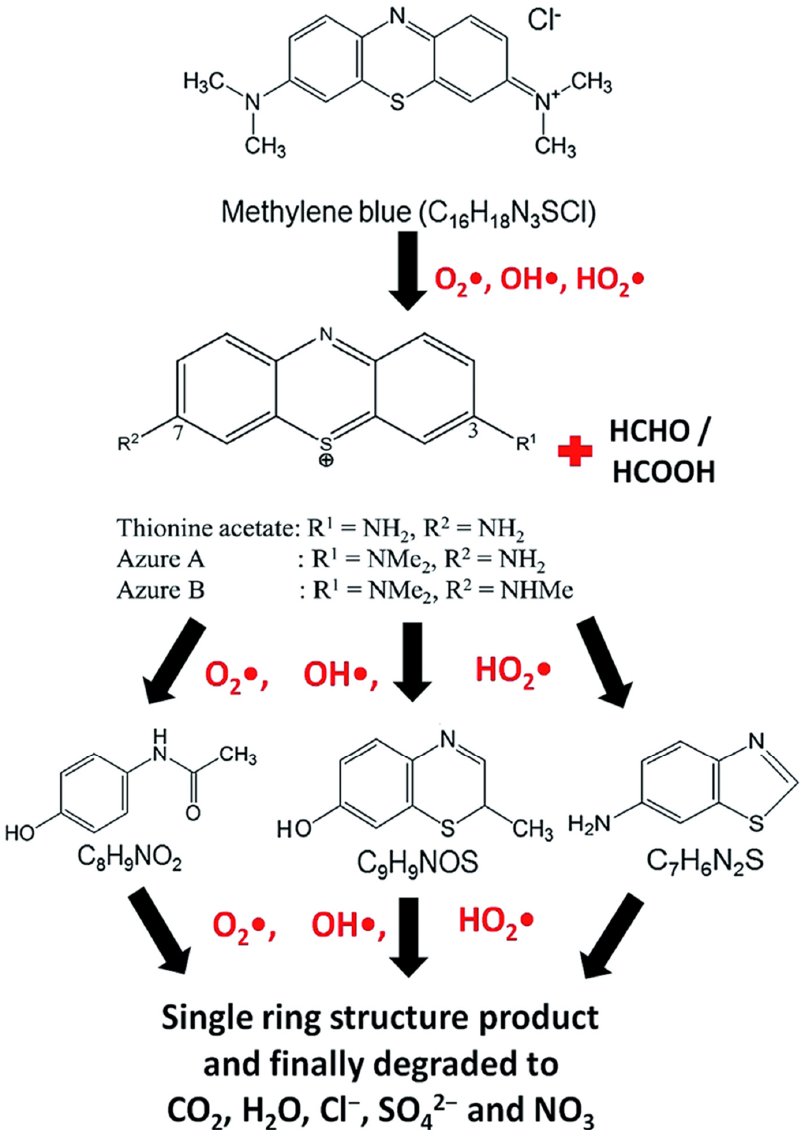
Figure 9. Probable reaction steps of MB photocatalytic degradation [67]. Adapted with permission from the Royal Society of Chemistry (license ID 1079849-3).